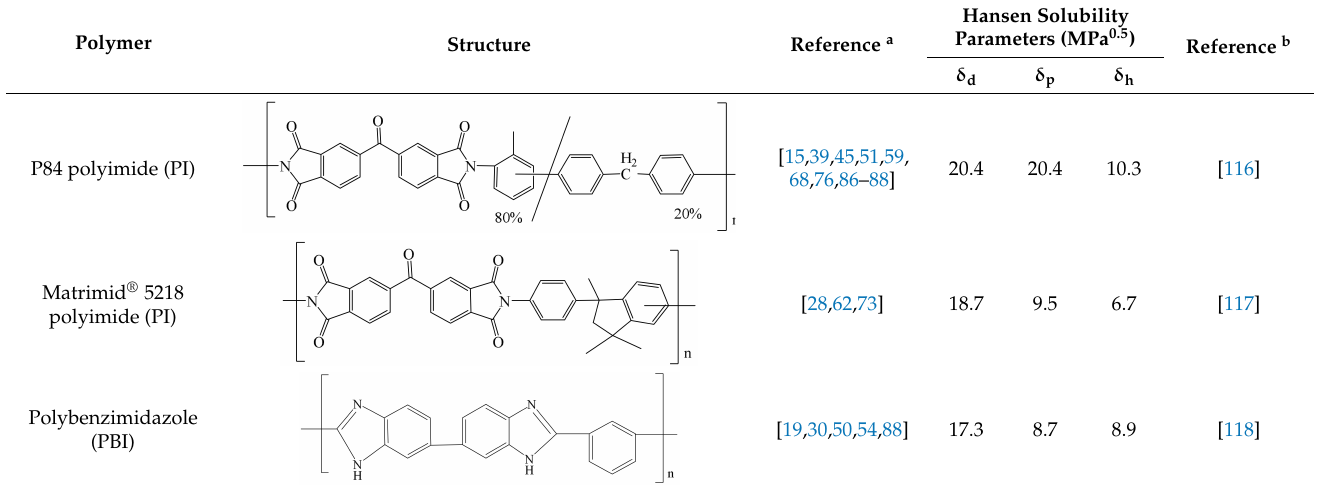
Table 5. The name, abbreviation, HSPs, and structure of the polymers to fabricate HF OSN membranes.